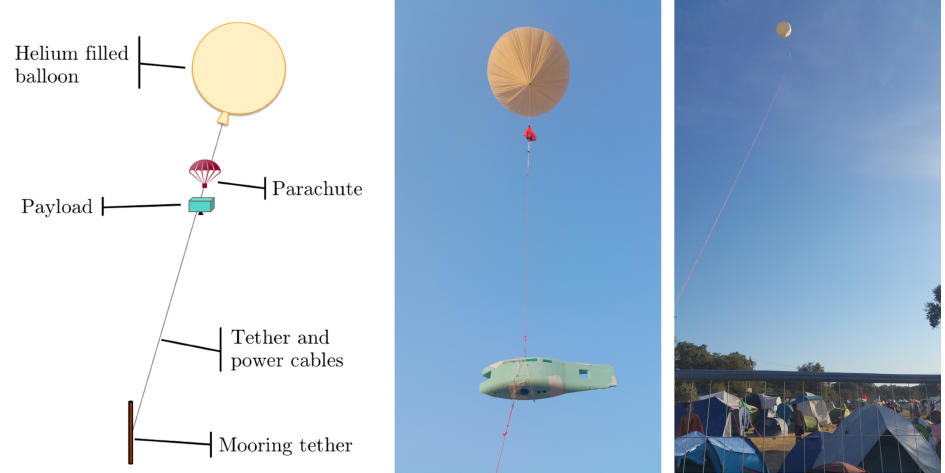
Figure 14. Thermal camera setup on tethered helium